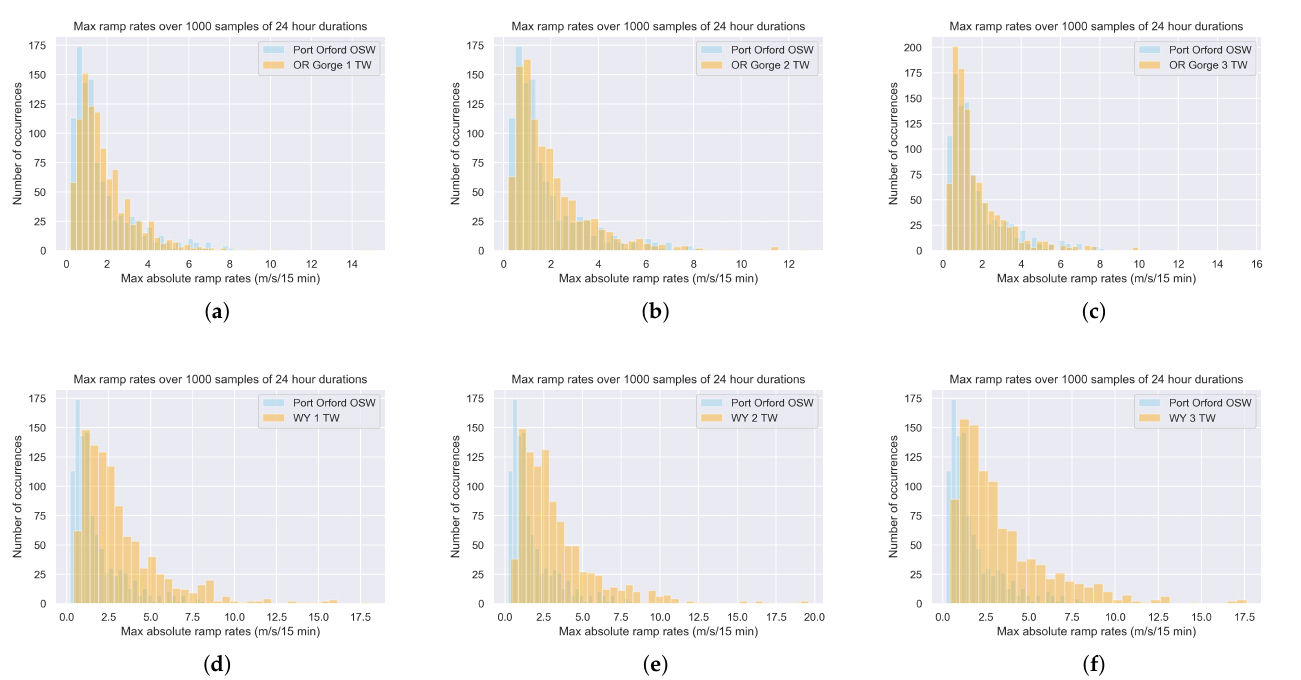
Figure 6. Distributions of absolute, 15-min ramps over 24-h periods, 2007–2012, Port Orford OSW vs. ( a – c ) Columbia Gorge TW and ( d – f ) Wyoming TW